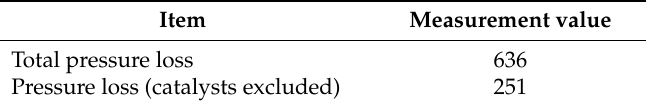
Table A6. Pressure loss in Experiment A2 (Pa). Item Measurement value